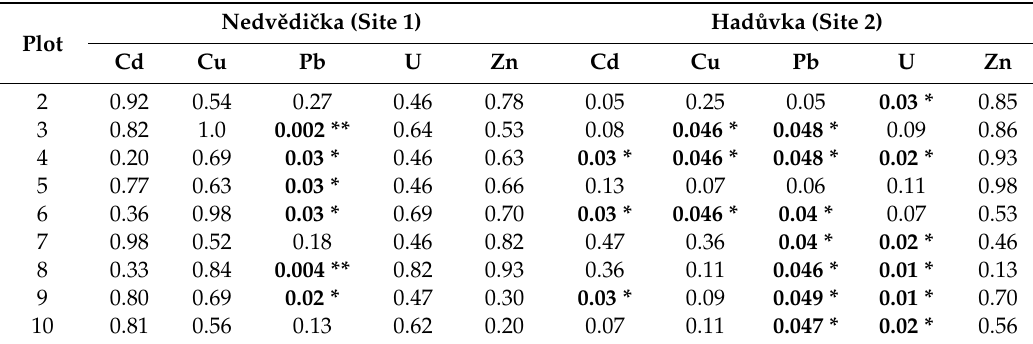
Table 2. p -values of the heavy metal and uranium contents in the leaves (DA) with dependence of distance from the contamination hotspot (statistically significant di ff erences from the plot 1 are highlighted in